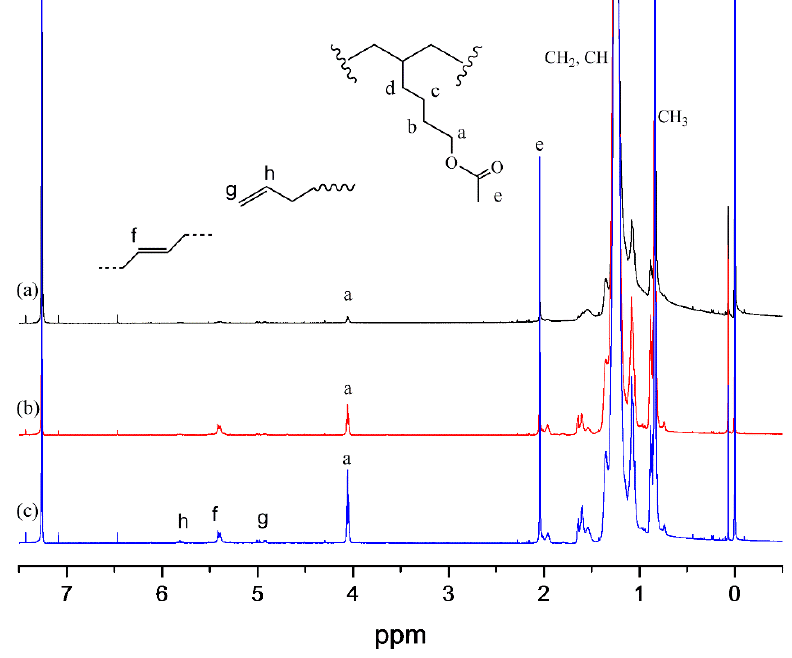
Figure 3. 1 H NMR spectra of the E-HAc copolymers: ( a ) 0.35 mol%; ( b ) 0.88 mol%; ( c ) 1.33 mol%.